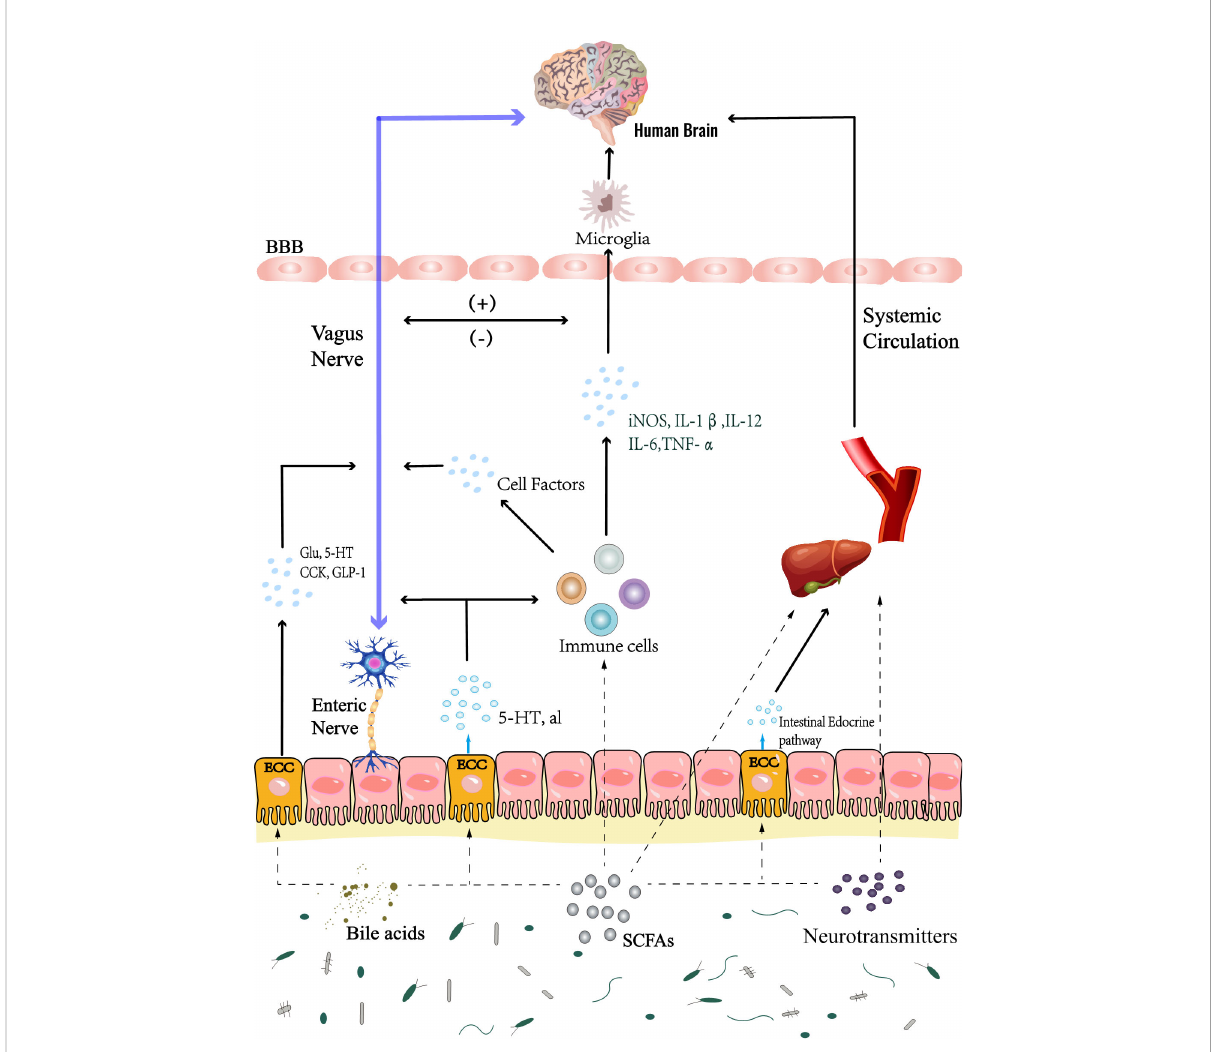
FIGURE 4 Gut microbiota mainly interacts with the brain through Chemical, Neuronal and Immune pathways. Metabolites of gut microbiota, such as SCFAs, neurotransmitters, bile acids, etc., directly affect the body and brain activities; In addition, the microbiota can also play this role by regulating the activities of enteroendocrine cells, such as ECCs. In the immune pathway, on the one hand, in fl ammatory factors can change the permeability of blood brain barrier and affect brain activity, these in fl ammatory factors also affect the brain resident immune cells; On the other hand, it can also affect brain in fl ammation through cellular immune pathway, which is through intestinal immune cells; Microbial metabolites also regulate the activities of brain resident immune cells. At the same time, in fl ammatory stimulation can also stimulate the vagus nerve, which also regulates brain activities, such as triggering the activation of HPA axis, pain conduction, etc. In addition, microbial metabolites and secretion of enteroendocrine cells directly affect the vagus nerve, or stimulate the intestinal nervous system to indirectly affect the vagus nerve, and establish a neural pathway to interact with the brain. SCFAs, short chain fatty acids. HPA axis, hypothalamic-pituitary-adrenal axis. ECCs, enterochromaf fi n cells. BBB, blood-brain barrier; Glu, glutamic acid; 5-HT, 5-hydroxytryptamine; CCK, cholecystokinin; GLP-1, glucagon-like